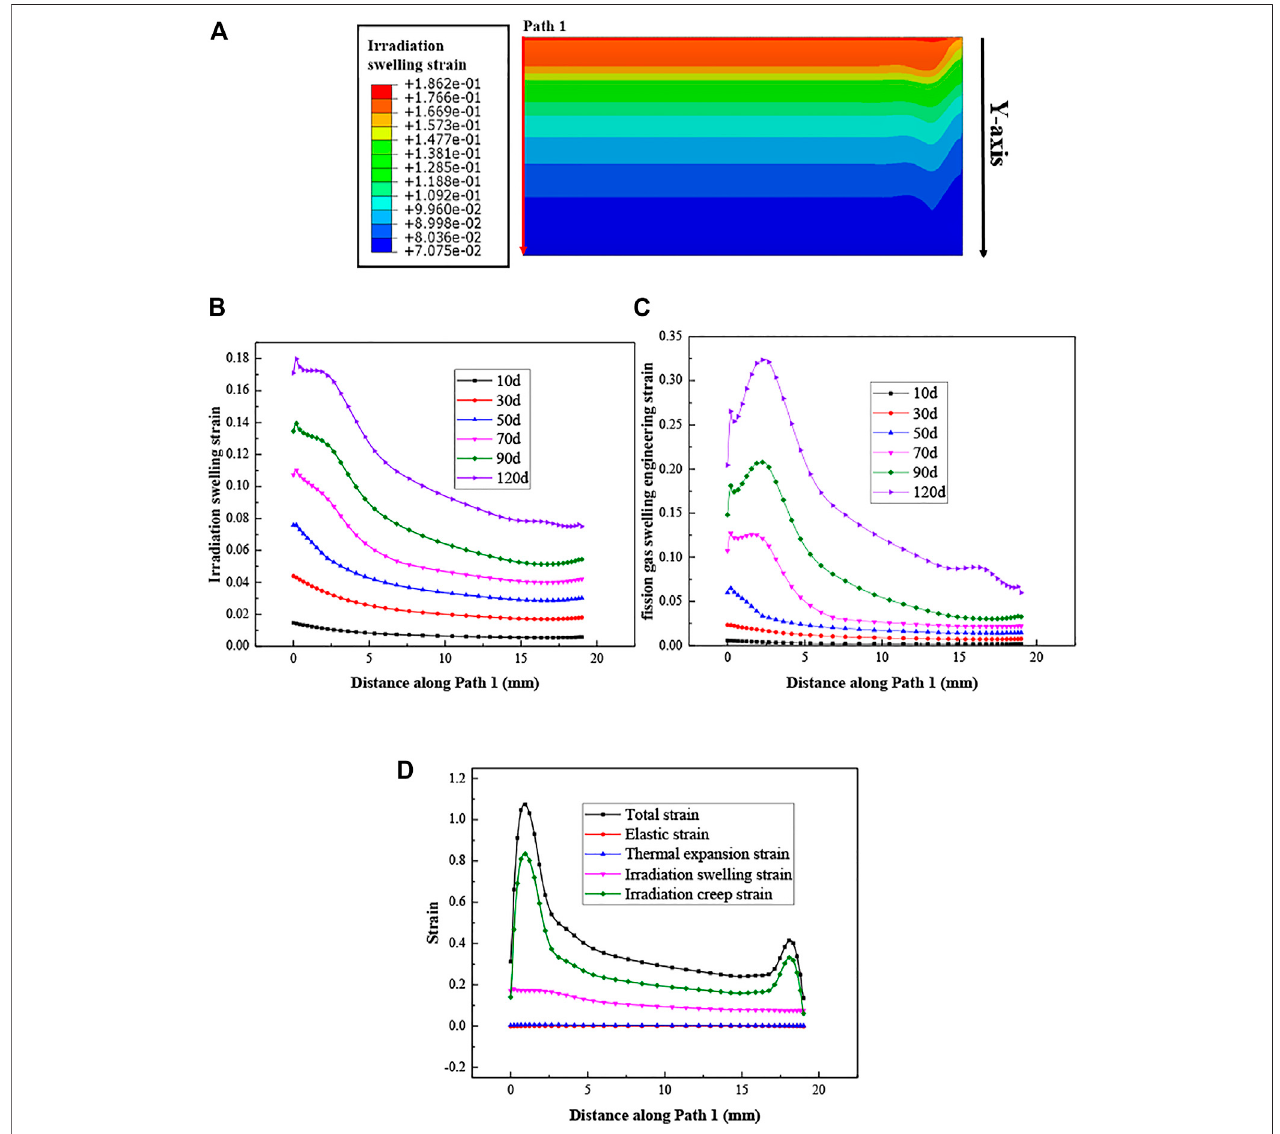
FIGURE10|(A) Thedistributionofthethicknessdisplacementofthefuelmeatafterthe120-daysirradiation; (B) Evolutionofthetotalirradiationswellingstrainand (C) the fi ssion gas swelling strain along Path 1; (D) Distribution of each strain on the 120 th day along Path 1.